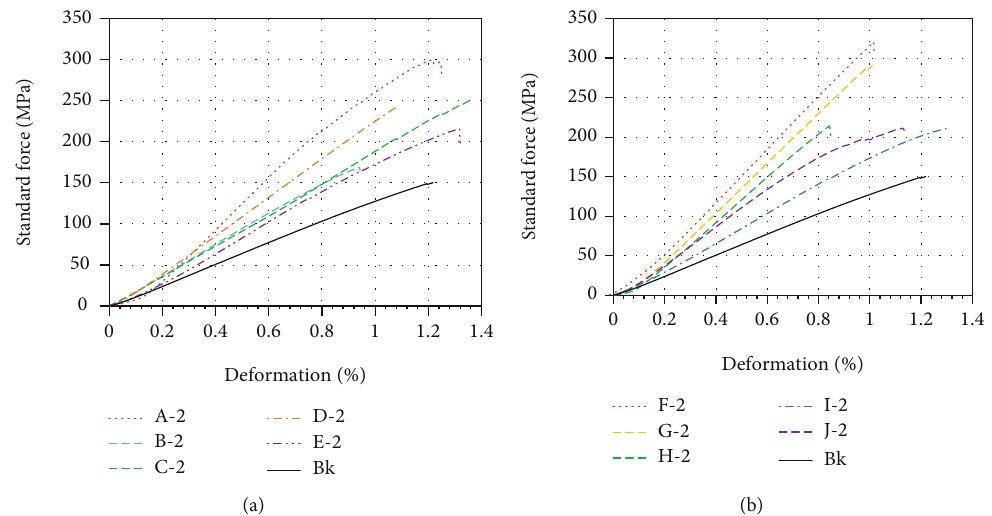
Figure 11: Flexural stress-strain plots of (a) dielectric material and (b) magnetic materials (A: MWCNTs, B: SiC, C: Gp, D: CB, E: MnO TiO , G: CoO, H: NiO, I: ZiO, J: Fe 2